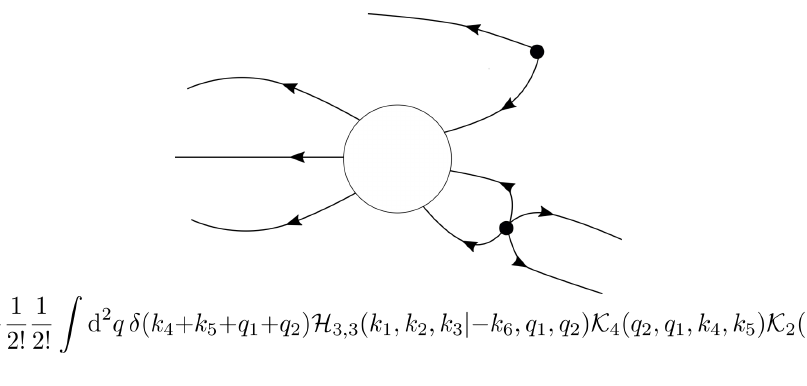
Figure 4: Above, we provide an example of a Feynman diagram contributing to ( k ) , together with its value. The symmetry factor in front of the integral I ,..., k 6 1 6 comes from the possible permutations of legs: more specifically, the factorials 3! and 2! come from the permutation of the triplet and pair of external legs, while an addi- tional term 2! is due to the permutations of the internal legs.